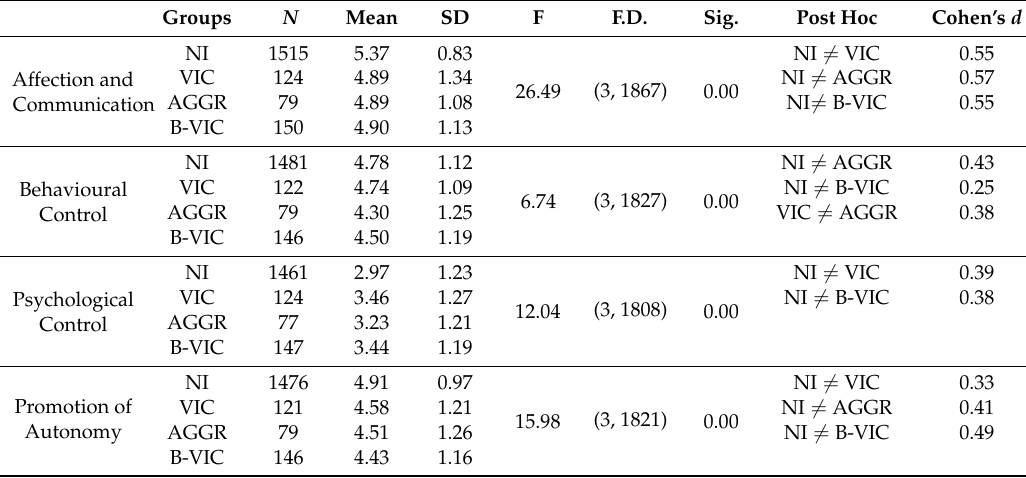
Table 2. ANOVA to determine the differences in parenting practices of mother according to the role of involvement in